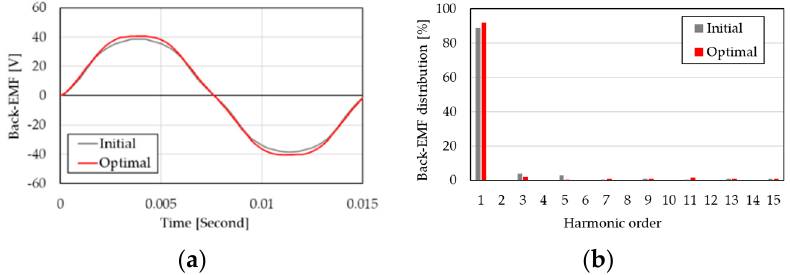
Figure 10. Comparison of the back-electromotive force (EMF) characteristics between the initial and the optimal models at no-load conditions (rotation speed at 1000 revolutions per minute (rpm): ( a ) Waveform; ( b ) Harmonic.